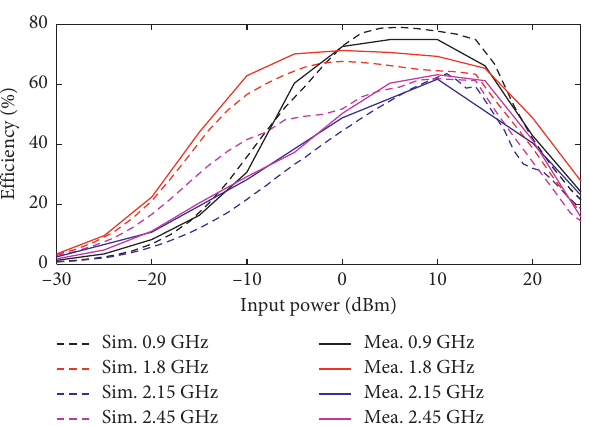
Figure 14: Simulated and measured conversion efficiency of the rectifier vs. input power level for multiband input signals.